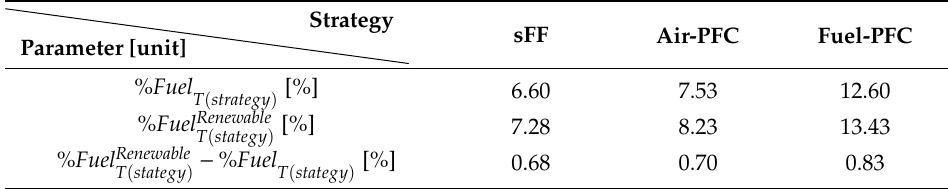
Table 6. Fuel economy of the FC system and FC / renewable HPS using the strategy air / fuel-PFC compared to the strategies sFF, air-PFC, and